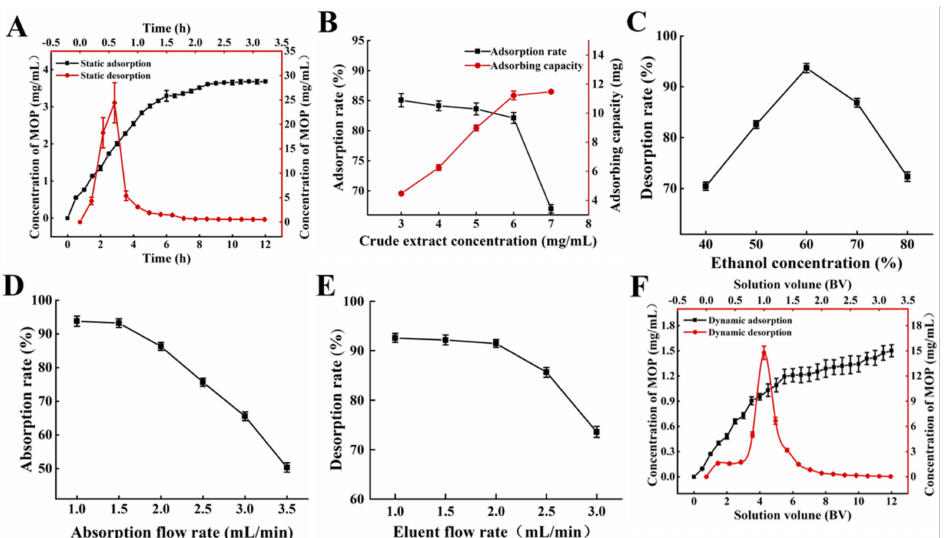
Figure 1. Adsorption and desorption capacities of NKA − 9 resin for polyphenols from MO. ( A ) Ki- netics for static adsorption and desorption on NKA − 9 resin for polyphenols from MO. ( B ) Effect of concentration of initial MOP on adsorption rate on NKA − 9 resin for polyphenols from MO. ( C ) Effect of eluent concentration on desorption rare on NKA − 9 resin for polyphenols from MO. ( D ) Effect of adsorption flow rate on adsorption rate on NKA − 9 resin for polyphenols from MO. ( E ) Effect of eluent flow rate on desorption rate on NKA − 9 resin for polyphenols from MO. ( F ) Kinetics for dynamic adsorption and desorption on NKA − 9 resin for polyphenols from